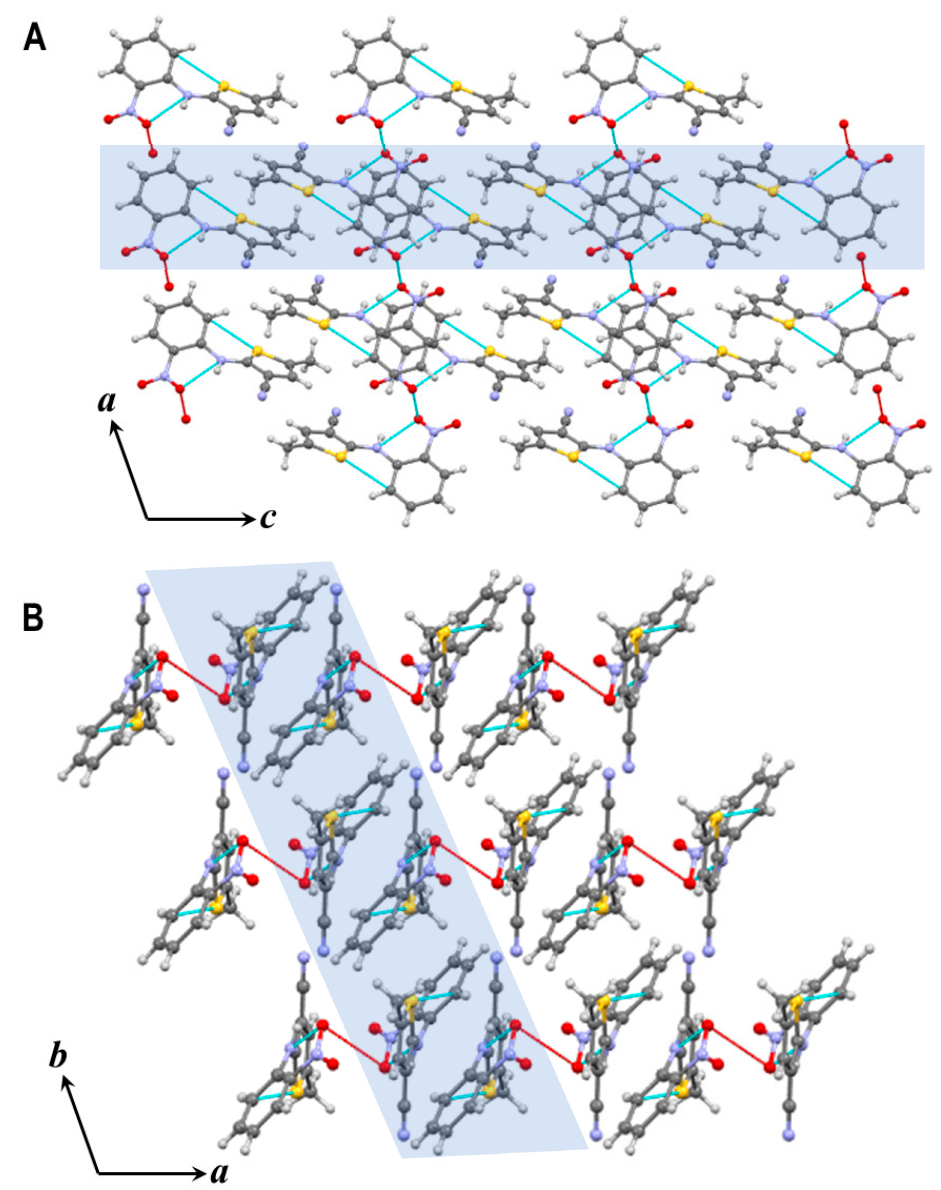
Figure 7. Crystal packing in polymorph R. ( A ) Viewed from the b axis; ( B ) viewed from the c axis. The shaded layer is (100).